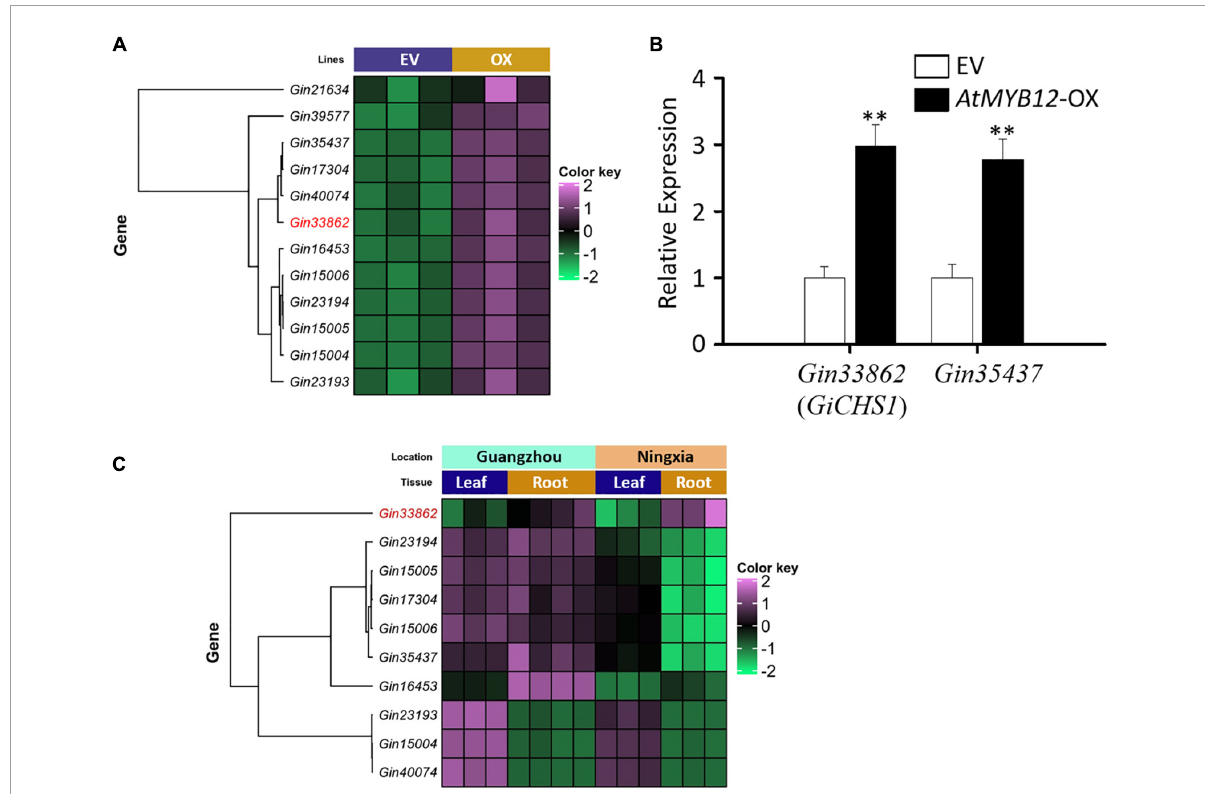
FIGURE2 Expression profiles of the G. inflata CHS genes induced by AtMYB12. (A) Heatmap shows the expression patterns of 12 GiCHS genes in EV and AtMYB12 -OX (OX) hairy root lines. Gin33862 ( GiCHS1 ) is highlighted in red. (B) Relative expression of two selected GiCHS genes in EV and AtMYB12 -OX hairy root lines measured by qRT-PCR. Values were normalized to the expression level of an internal control, the actin gene ( GiActin ). Data presented are the means of three biological replicates ± SD ( n = 3). Asterisks indicate statistically significant differences compared with EV lines ( ∗∗ p < 0.01, Student’s t -test). (C) Heatmap shows the expression patterns of 10 GiCHS genes in two tissues (root and leaf) collected from two locations (Guangzhou and Ningxia) in